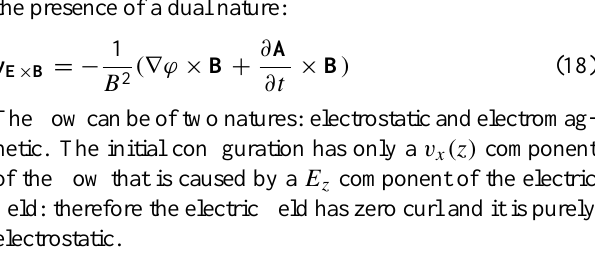
The tearing mode is a mode primarily involving the evolu- tion of the out of plane component of the vector potential A and it is inductive in nature since it produces an elec- tromagnetic field thanks to the topological variations of B . However, in presence of out of plane components of the field, there is also an electrostatic potential associate with it (Daughton and Karimabadi, 2005). The viscous effect alone, instead, does not directly affect